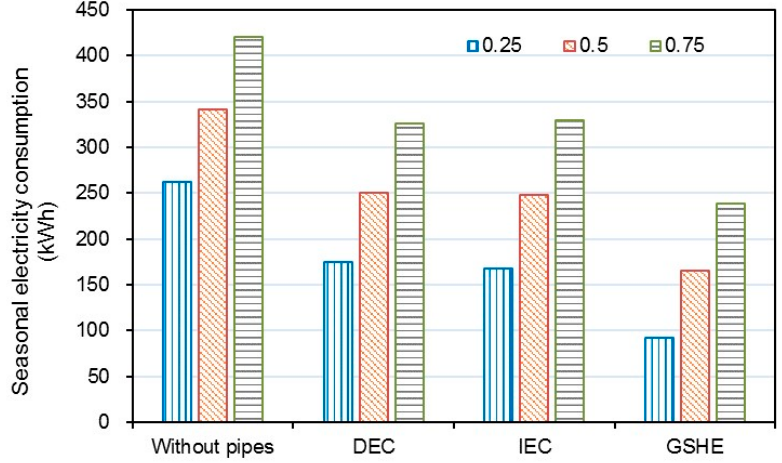
Figure 14. Seasonal electricity consumption of the offices with different WWRs.